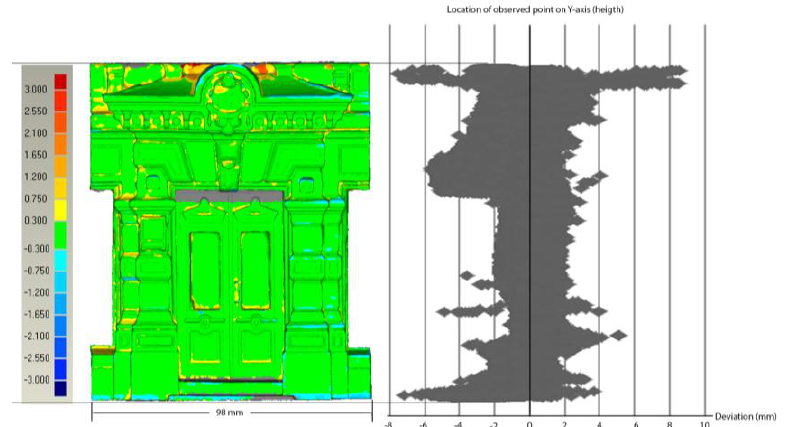
Figure 13. Deviation analysis and scatter of the Façade segment model